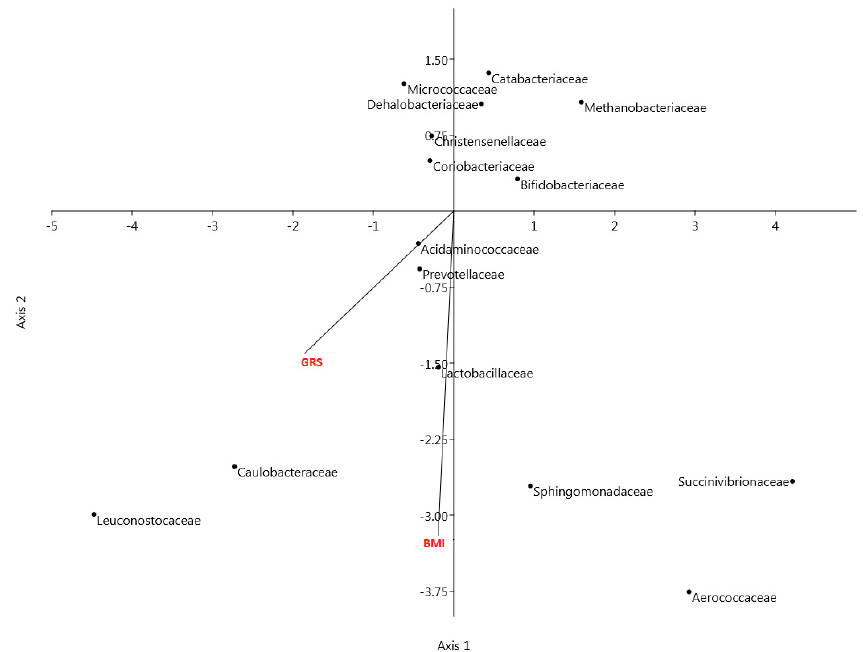
Figure 3. Biplot of the analysis of multivariate ordination with canonical correspondence analysis (CCA) applied to taxonomic abundance comparison at family level (including families obtained by LEfSe). CCA was performed to assess the variance in microbiota profiles at the family level in lean and overweight + obese, high GRS and low GRS and men and women. Vectors represent the environmental variables (in red) and black points represent abundance of families.